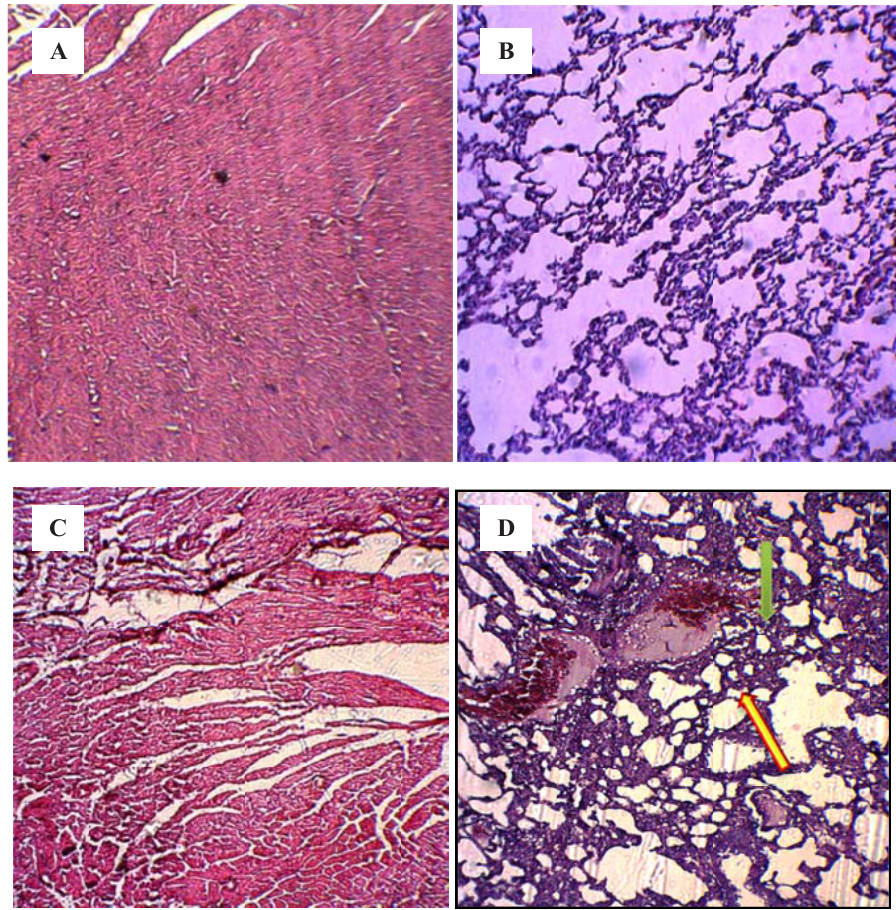
Fig. 2. Photomicrographs of heart and lung sections obtained from rats exposed to carbon nanotubes. Panels A and B: controls. Panel Fig. 2. Ph C: myocardium tissue of rats exposed to carbon nanotubes. Panel D: lung tissue from treated rats with carbon nanotubes. (A) Normal heart, (B) normal lung, (C) myocytolysis, (D) green arrow shows hemorrhage and blue arrow shows alveolar edema. (Staining with hematoxylin and eosin). Magnification: 40x for